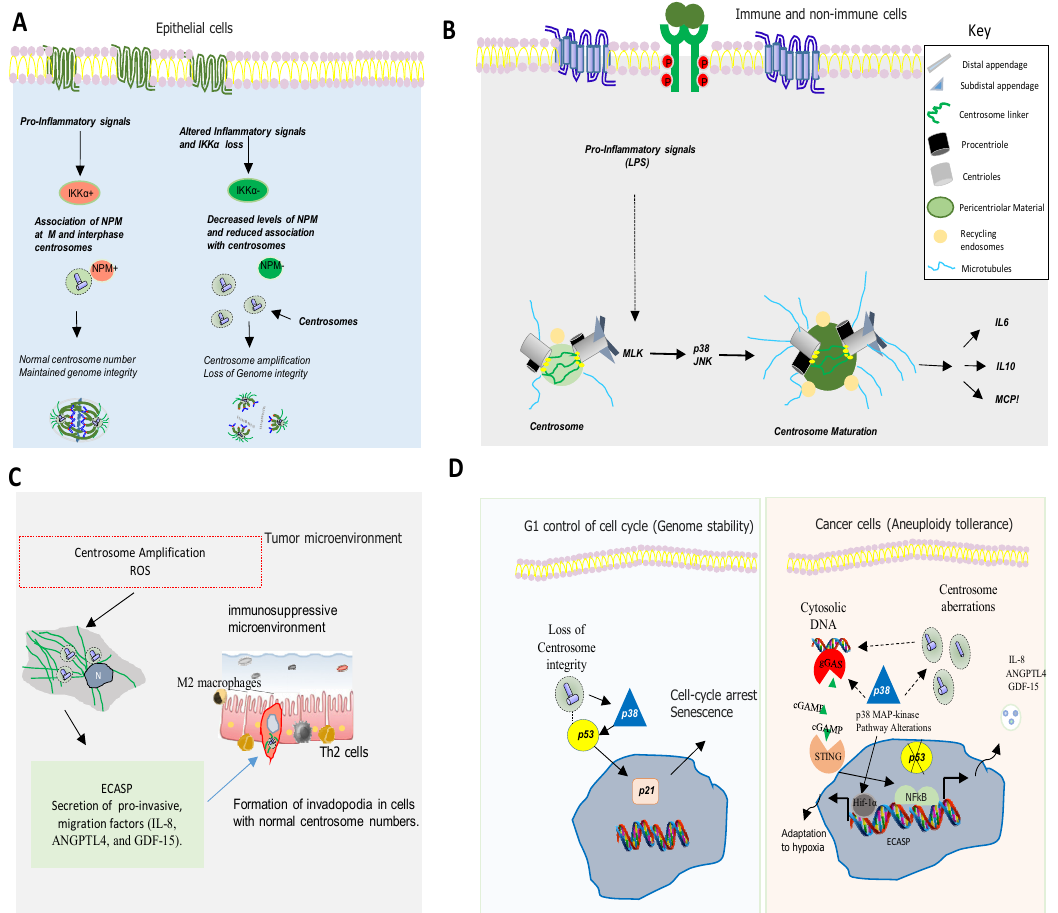
Figure 3. Chromosome instability in cancer and inflammatory responses. ( A ) Pro-inflammatory cytokines activate the IKK α /Nucleophosmin (NPM) hexamer formation and centrosome interplay in mouse and human cells [40]. IKK α activation and increased NPM levels (red) allow NPM-Centrosome interaction, which allows the maintenance of normal centrosome number and genome integrity. Right, IKK α or NPM loss (green), decreases the levels of NPM hexamers and the association of NPM with centrosomes, thereby promoting centrosome amplification and genome changes that predispose to cancer [40]. ( B ) Exposure to LPS induces the axis MLK-p38-JNK which is critical for interphase centrosome maturation and secretion of inflammatory cytokines by immune and non-immune cells. ( C ) Centrosome amplification facilitates the release of proinvasive factors (ECASP) to induce non-cell-autonomous invasion. Although it remains undetermined how the additional centrosomes promote the ECASP, it is dependent on elevated levels of reactive oxygen species in cells with amplified centrosomes. The release of proinvasive factors is required for invadopodia formation in cells with normal centrosomes. Chronic NF- κ B activation mediates the ECASP through the regulation of proteins, including IL-8, to shape the immunosuppressive microenvironment. ( D ) Loss of centrosome integrity activates p38-p53-p21 pathway resulting in cell-cycle arrest or senescence acting as a cell-cycle checkpoint pathway. In cancer cells, centrosome dysfunction leads to the generation of cytosolic dsDNA, which in turn, activates the cGAS–STING and alternative inflammatory pathways such as NF- κ B signaling leading to ECASP. Centrosome abnormalities in cooperation with p38 and p53 dysfunction can also lead aneuploidy tolerance and adaptation to